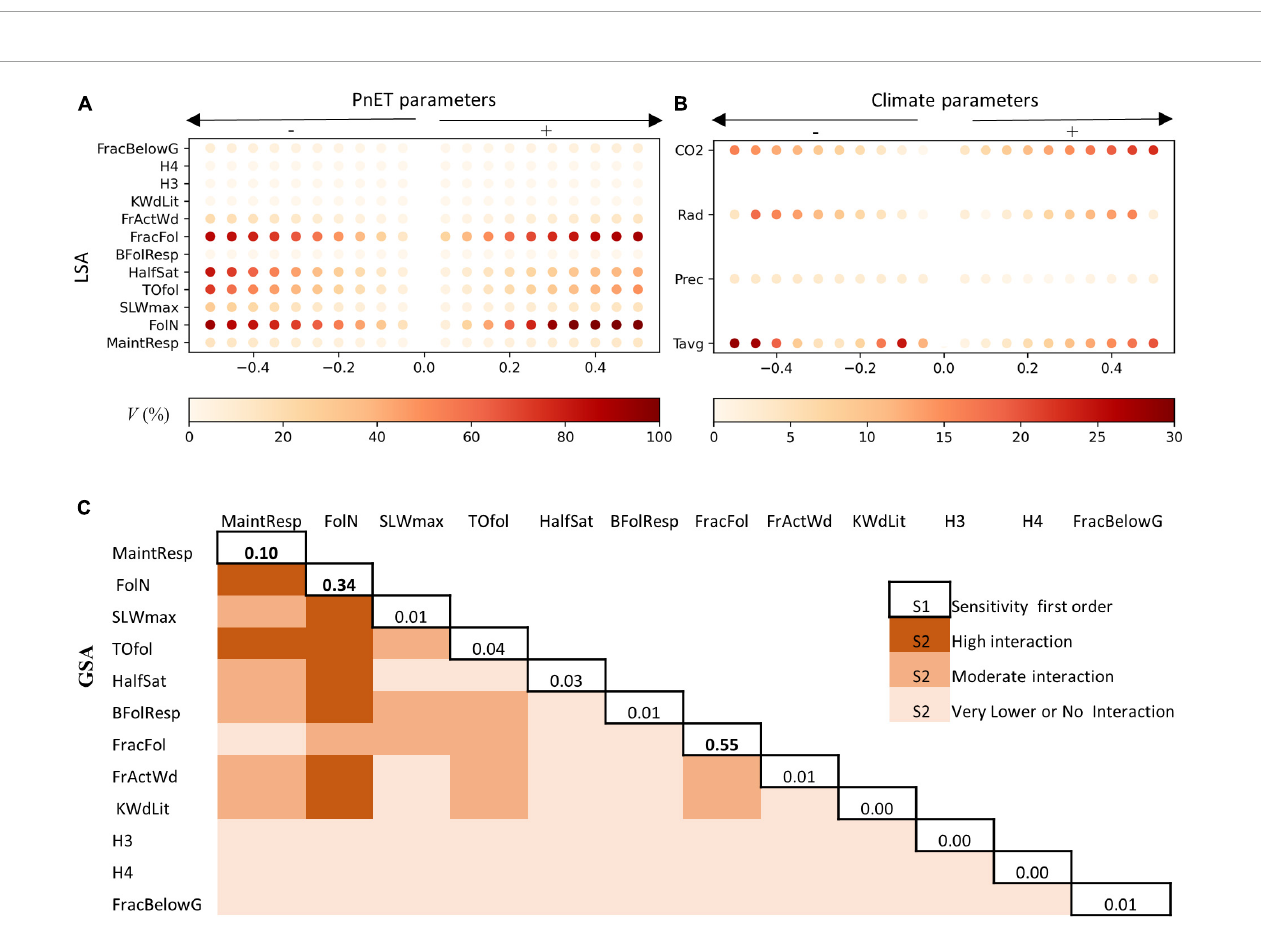
FIGURE4 (A) Local sensitivity analysis (LSA) of the 12 PnET model parameters in 2050, where V is the variation percentage compared to the reference values, the signs –/+ reflect the decreasing/increasing in biomass variation. (B) LSA of CO 2 concentration and climate parameters (P, precipitation; Tavg, average temperature of Tmin and Tmax; Rad, radiation), (C) global sensitivity analysis using Sobol algorithm, the diagonal values represent the sensitivity of first order, well the other values reflect the sensitivity of the second-order (S2) (interaction), (lower: S2 < 0.05) (moderate: 0.05 < S2 < 0.10) (high: S2 >